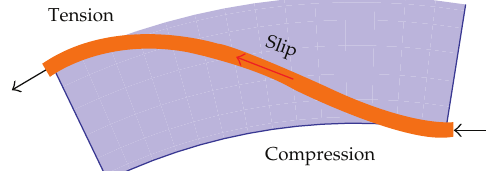
Figure 1: Slip of helix elements in bending.